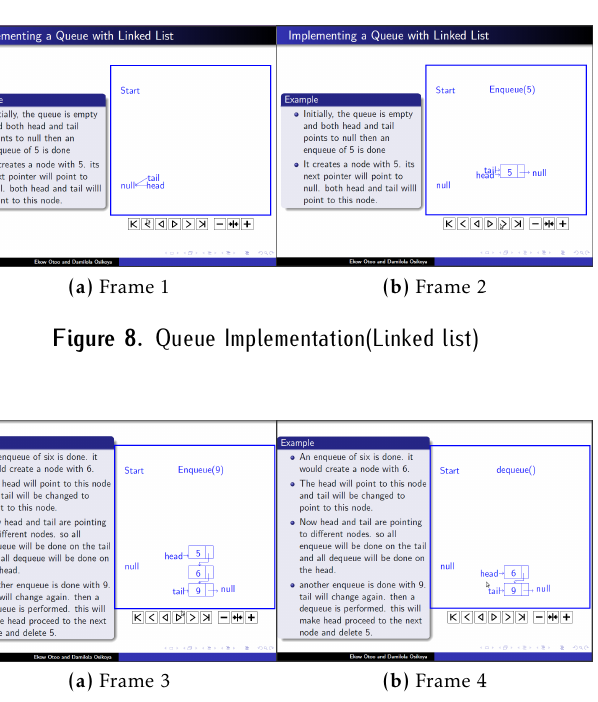
Figure 9. Queue Implementation(Linked list) tells weather its a leaf node. The figure below shows controlled animated frames of an insert algorithm in a binary tree.